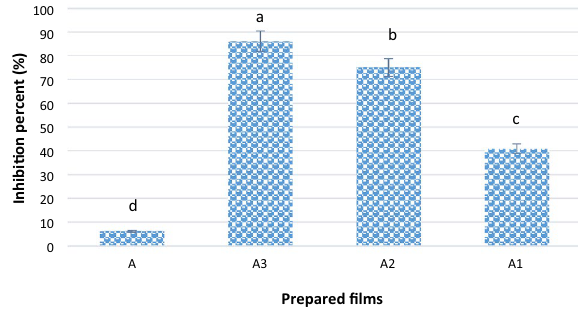
Figure 4. Inhibition percent of different prepared films.